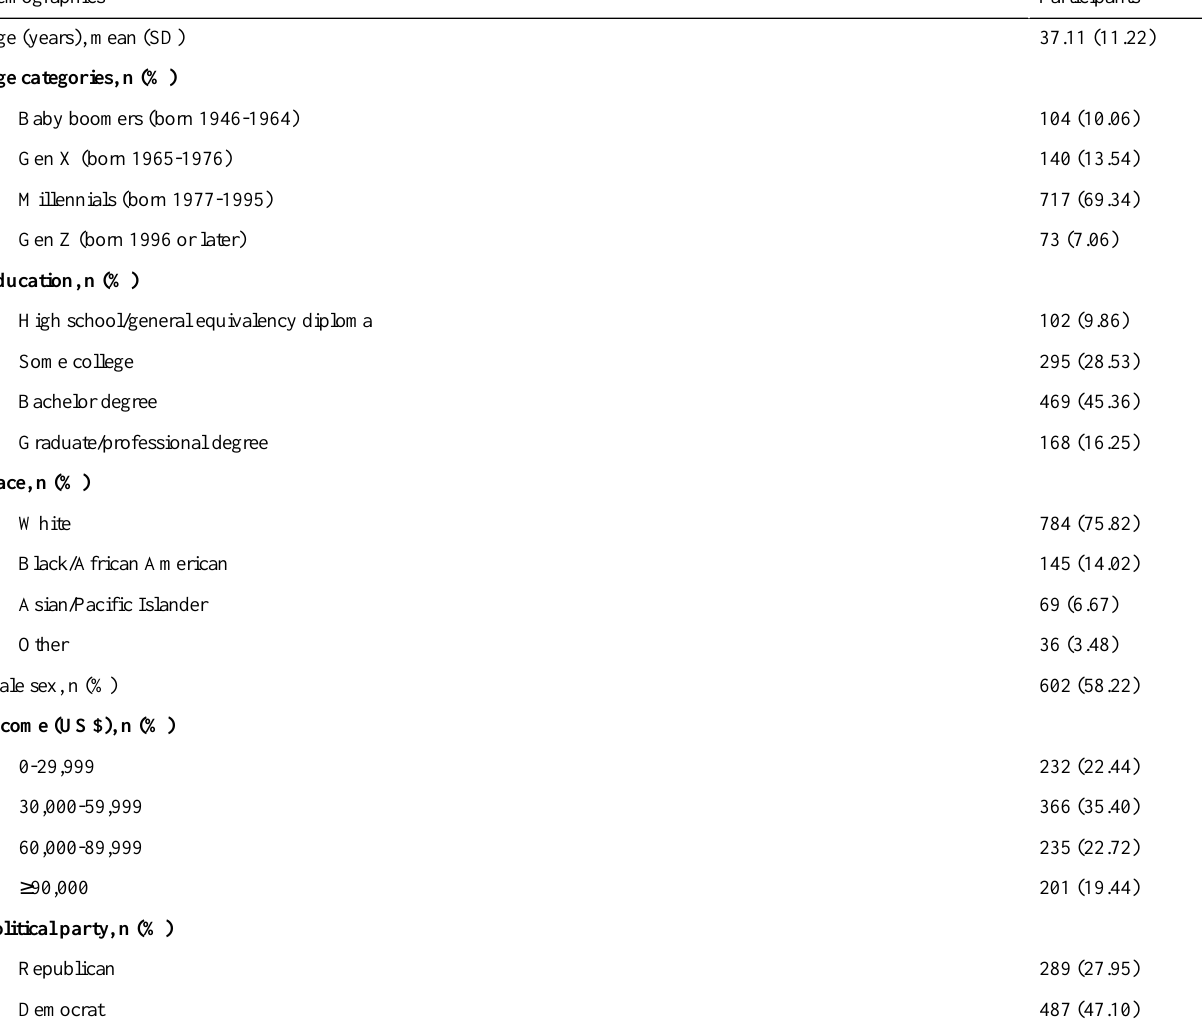
Table 1. Demographics and COVID-19 knowledge and behaviors of participants